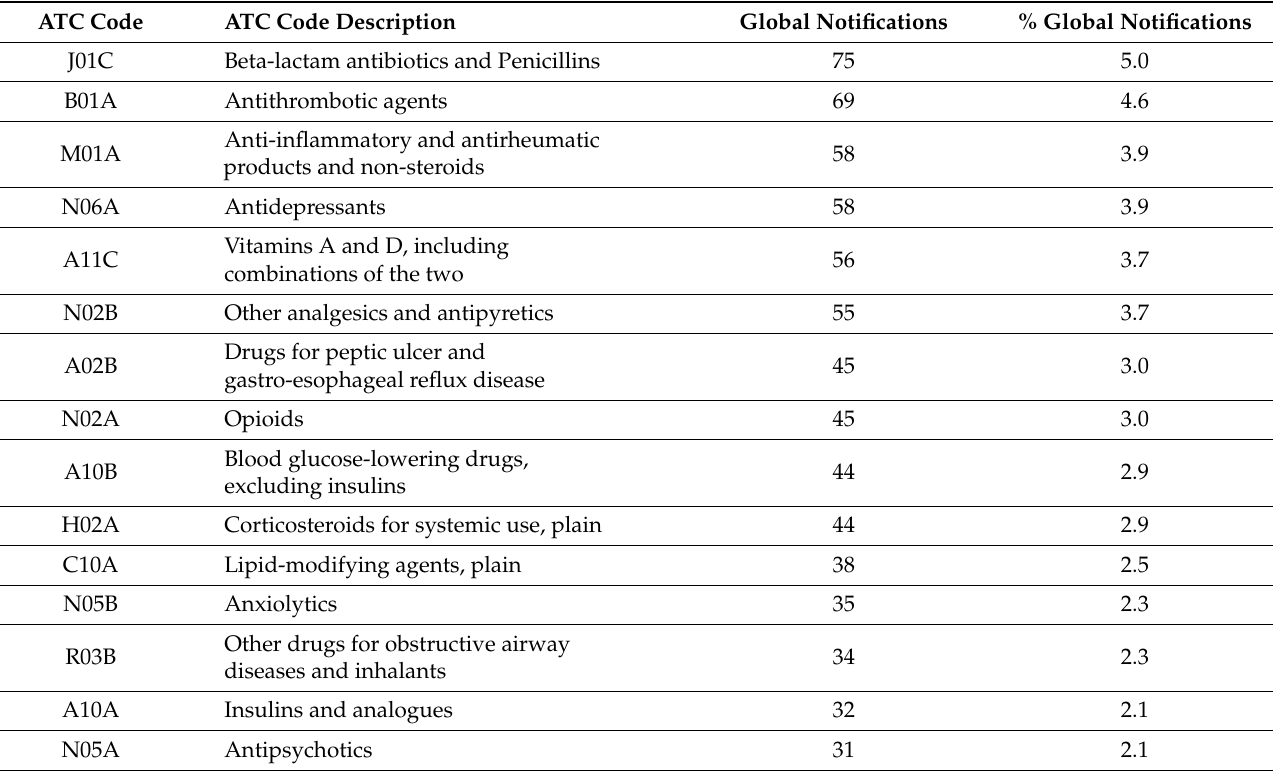
Table 4. Numbers and percentages of the drugs most frequently involved in the MEs reported, according to the classifications by therapeutic group based on the ATC code descriptions (Catalonia,